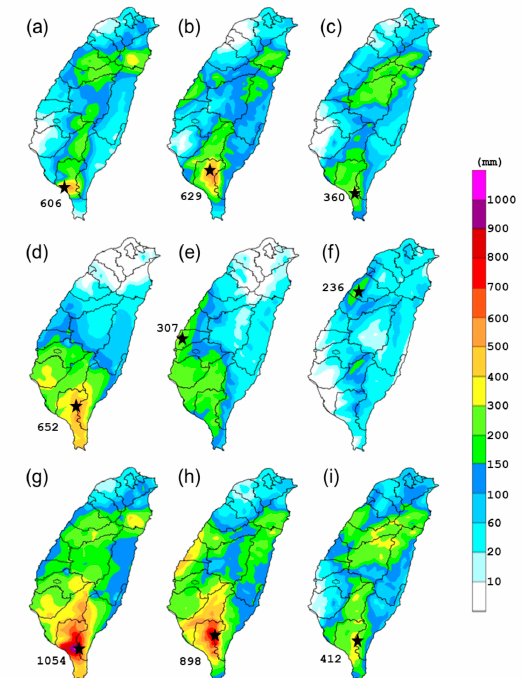
Figure 12. The 0~24-h accumulated rainfall (mm) from ( a ) observed, ( b ) V2D2, and ( c ) V1D3 initiated at 0000 UTC 29 July 2017. ( d – f ) and ( g – i ) as in panels ( a – c ), except for the 24~48-h and 0~48-h accumulated rainfall, respectively. The digital numbers denote the maximum rainfall which occurred at the position marked as a star sign.